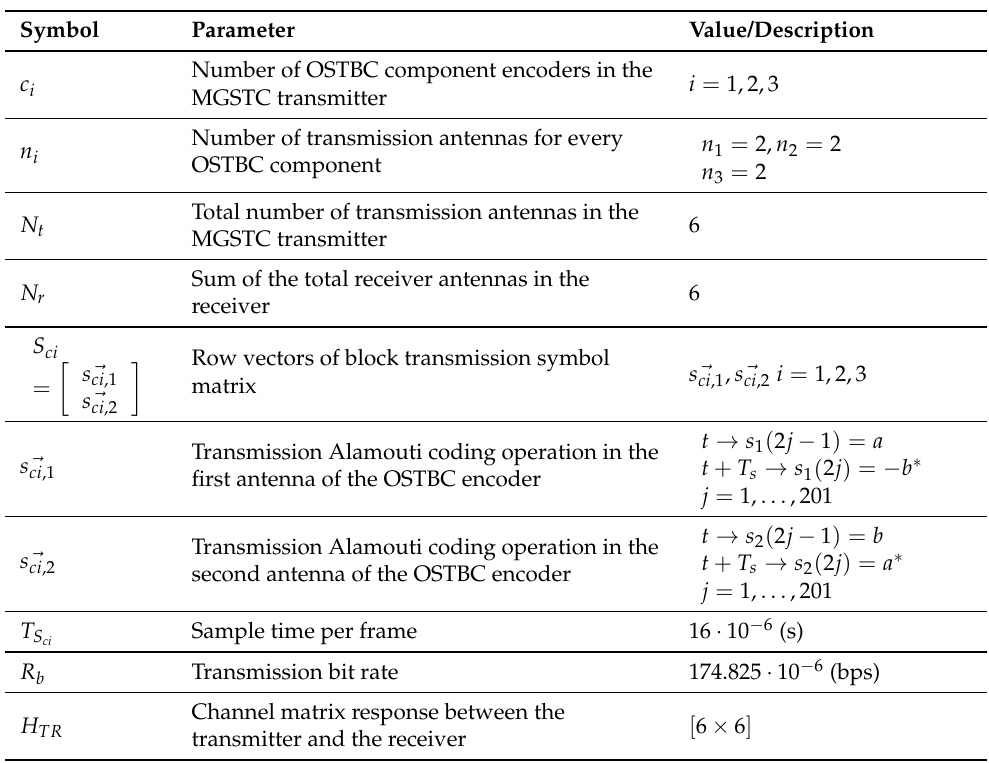
Table A1. Units and parameters used in the conducted